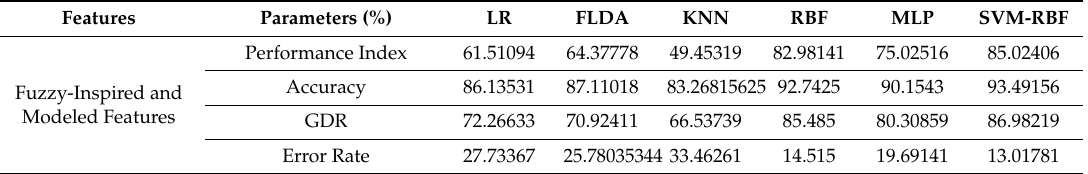
Table 15. Average performance of parameters among the classifiers at various optimization techniques with di ff erent features for CVD